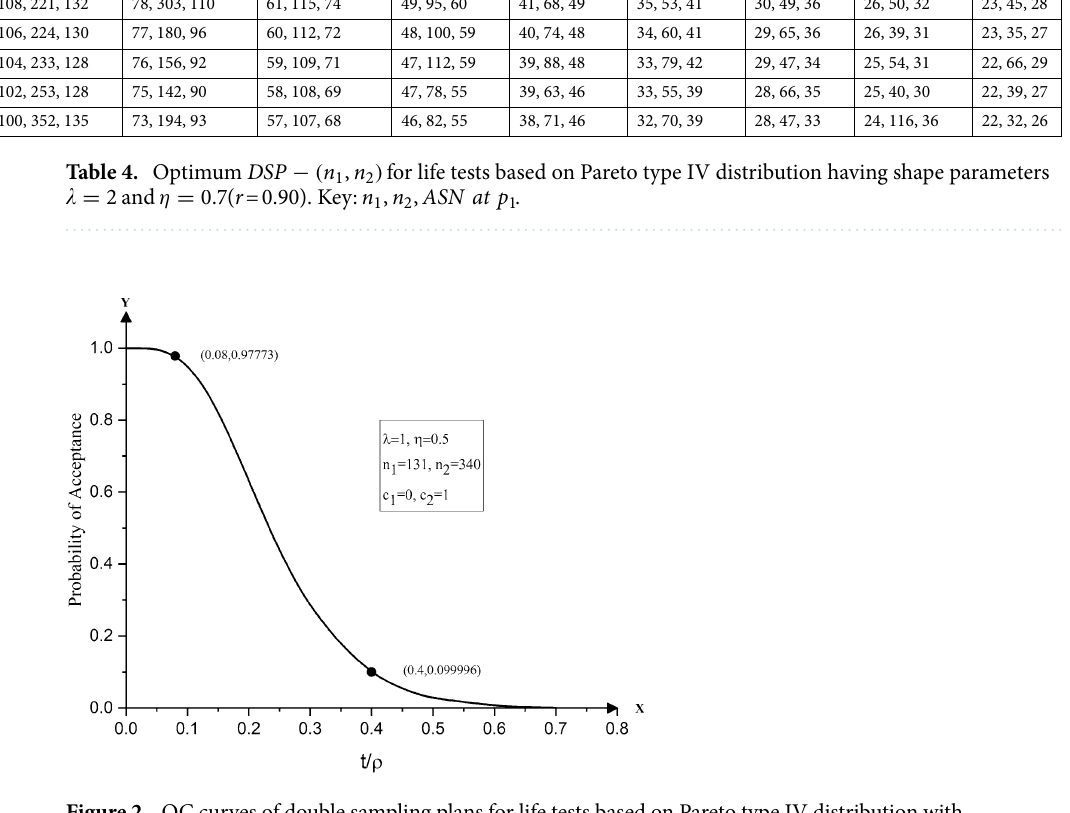
Figure 2. OC curves of double sampling plans for life tests based on Pareto type IV distribution with = 131, n = 340, (cid:31) = 1 and η = 0.5 n 1 2